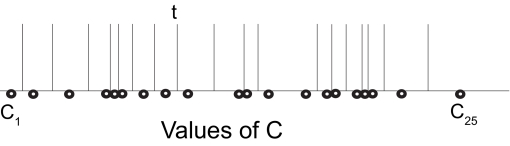
Possible threshold values for a continuous attribute, C